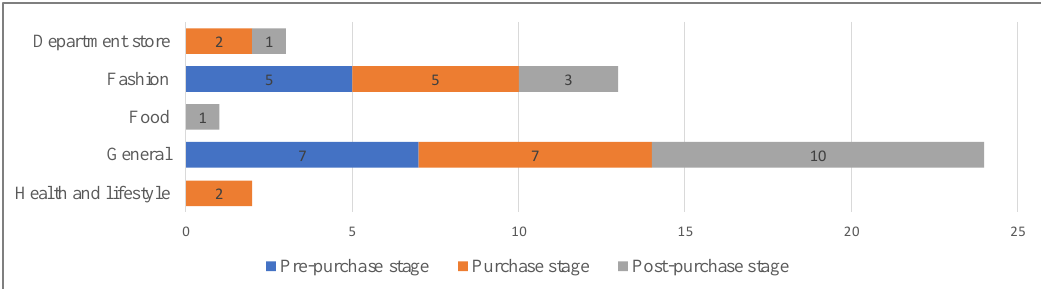
Figure 3. Annual distribution of the retail sectors studied over time. Regarding the quality of the publications according to the SJR ranking, the 43 selected articles are from journals in the 1–3 quartile, involving 32 different journals, which demon- strates, once again, the coverage of the selected literature. Table 1 presents the journals with the highest number of publications in the